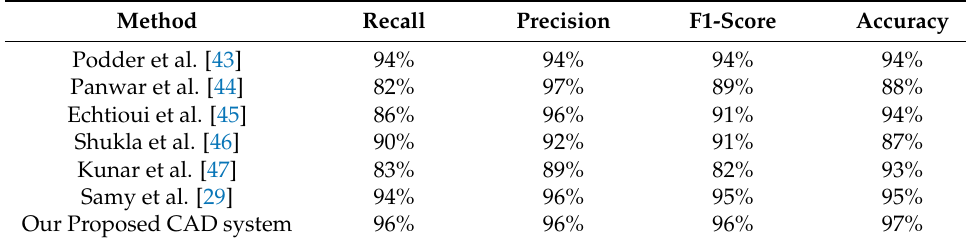
Table 6. Performance comparison of proposed work with earlier works.